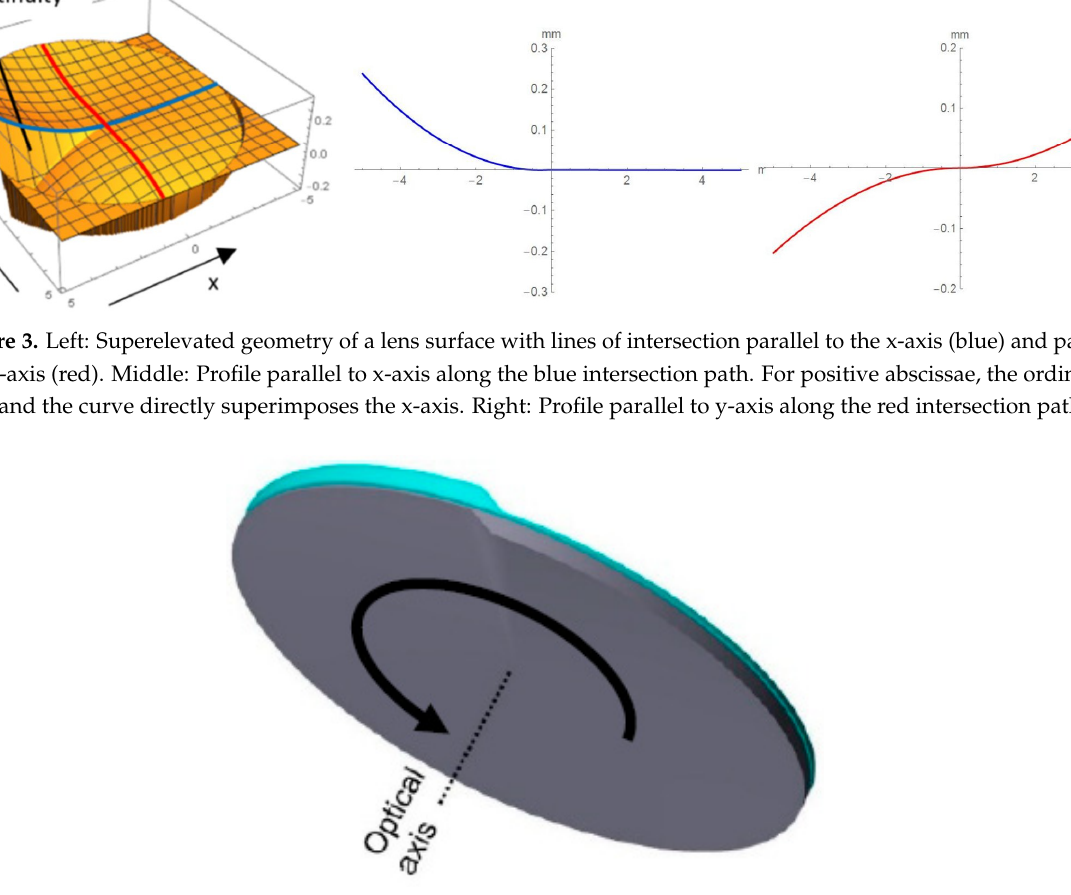
Figure 4. Rotation optics, consisting of two lens bodies with surfaces of azimuthal curvature de- pendence arranged coaxially to the optical axis and their plane surfaces facing each other [27].